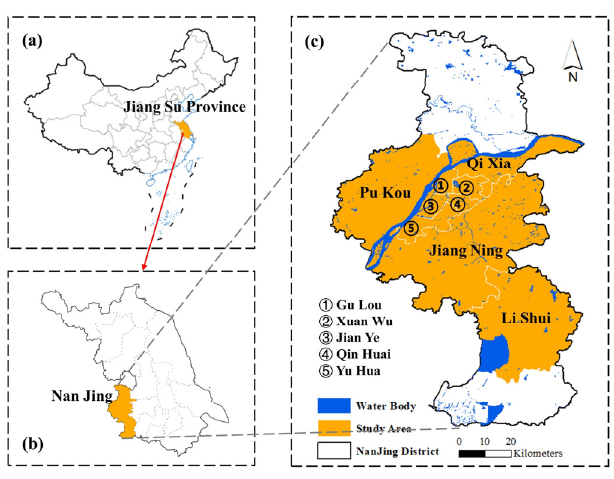
Figure 1. Study area: ( a ) Jiangsu, China; ( b ) Nanjing, Jiangsu; ( c ) extent of the study area.